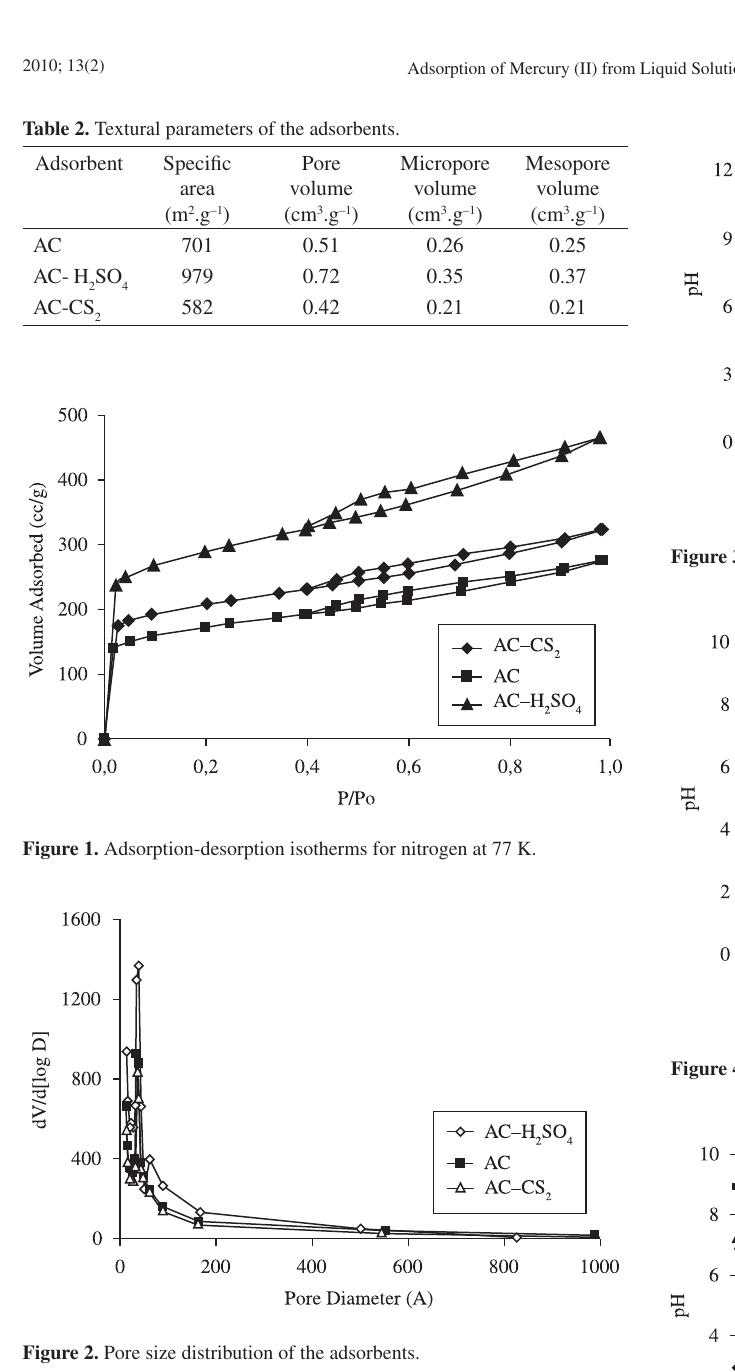
Figure 2. Pore size distribution of the adsorbents.